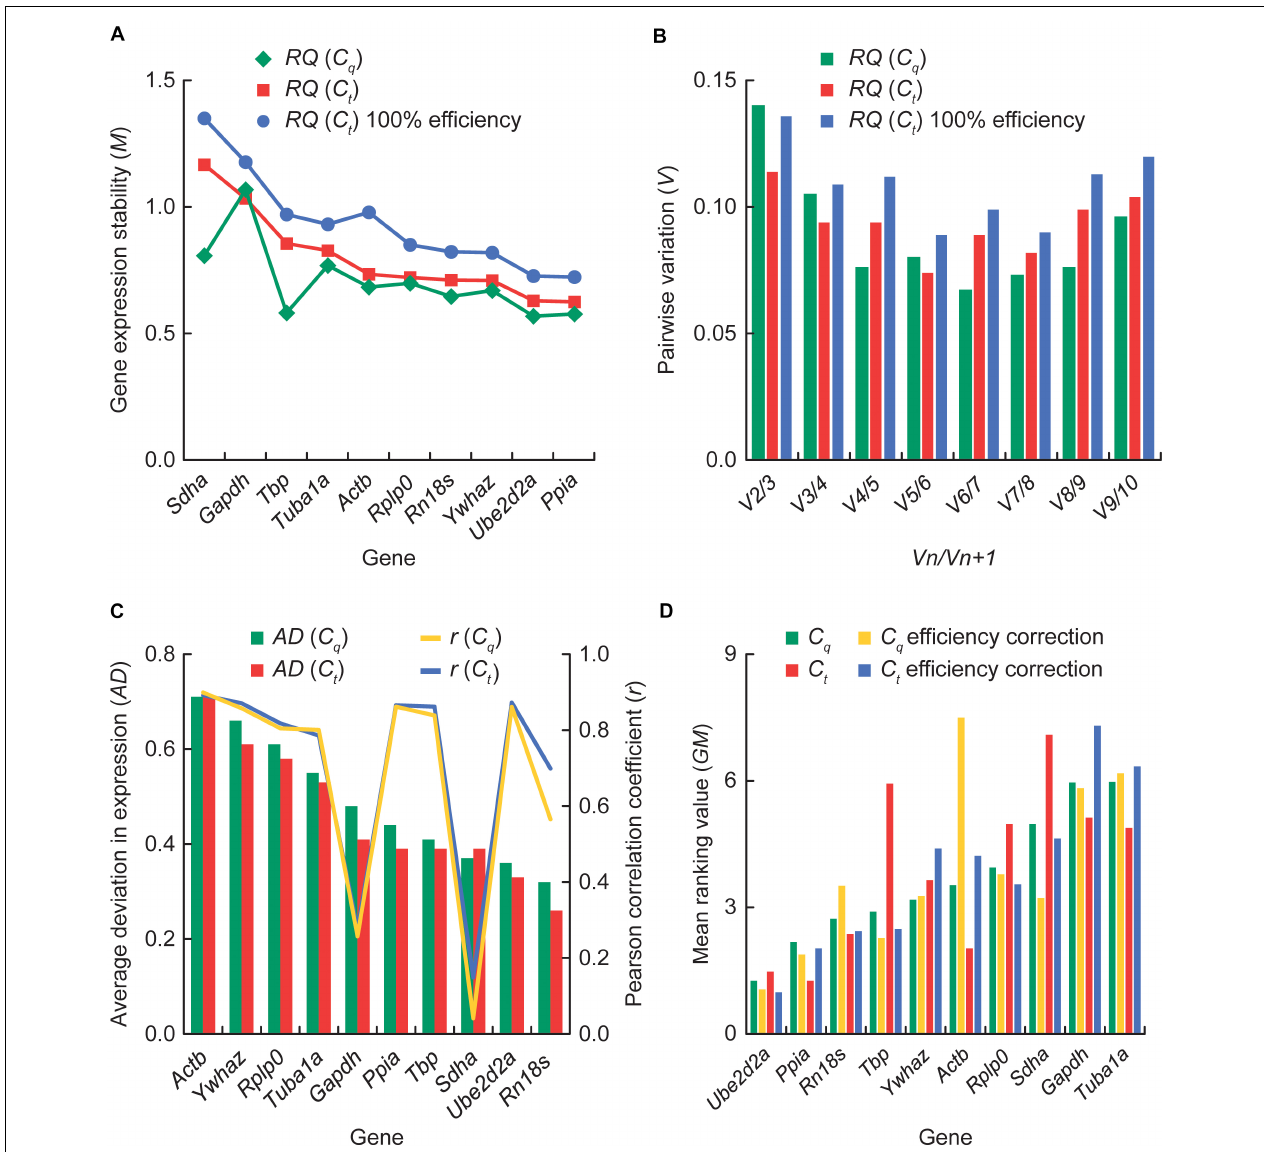
FIGURE 3 | Gene expression stability analysis. (A) The average expression stability ( M ) calculated with geNorm, with the more stable genes toward the right-hand end of the graph. For comparison, results based on the relative quantity ( RQ ) estimated from the second derivative ( C q ) data are shown along with those based on the threshold cycle ( C t ) data assuming either reaction-specific or 100% qPCR efficiency. (B) Pairwise variation ( V n / V n + 1 ) calculated with geNorm for two sequential sets containing an increasing number of genes. A value below 0.15 indicates that the addition of another gene has no significant effect in data normalization. (C) BestKeeper ranking by decreasing average deviation ( AD ) in gene expression values. Pearson correlation coefficient ( r ) of the expression level of each gene with the BestKeeper Index (the geometric average of all genes) is also shown. For comparison, results based on the C q data are shown along with those based on the C t data. (D) Comprehensive ranking with RefFinder by the geometric mean of the ranking weights assigned to each gene based on the results from geNorm, NormFinder, BestKeeper, and the (cid:49) C q method. Results based on efficiency corrected and non-corrected C q and C t values are shown for comparison.